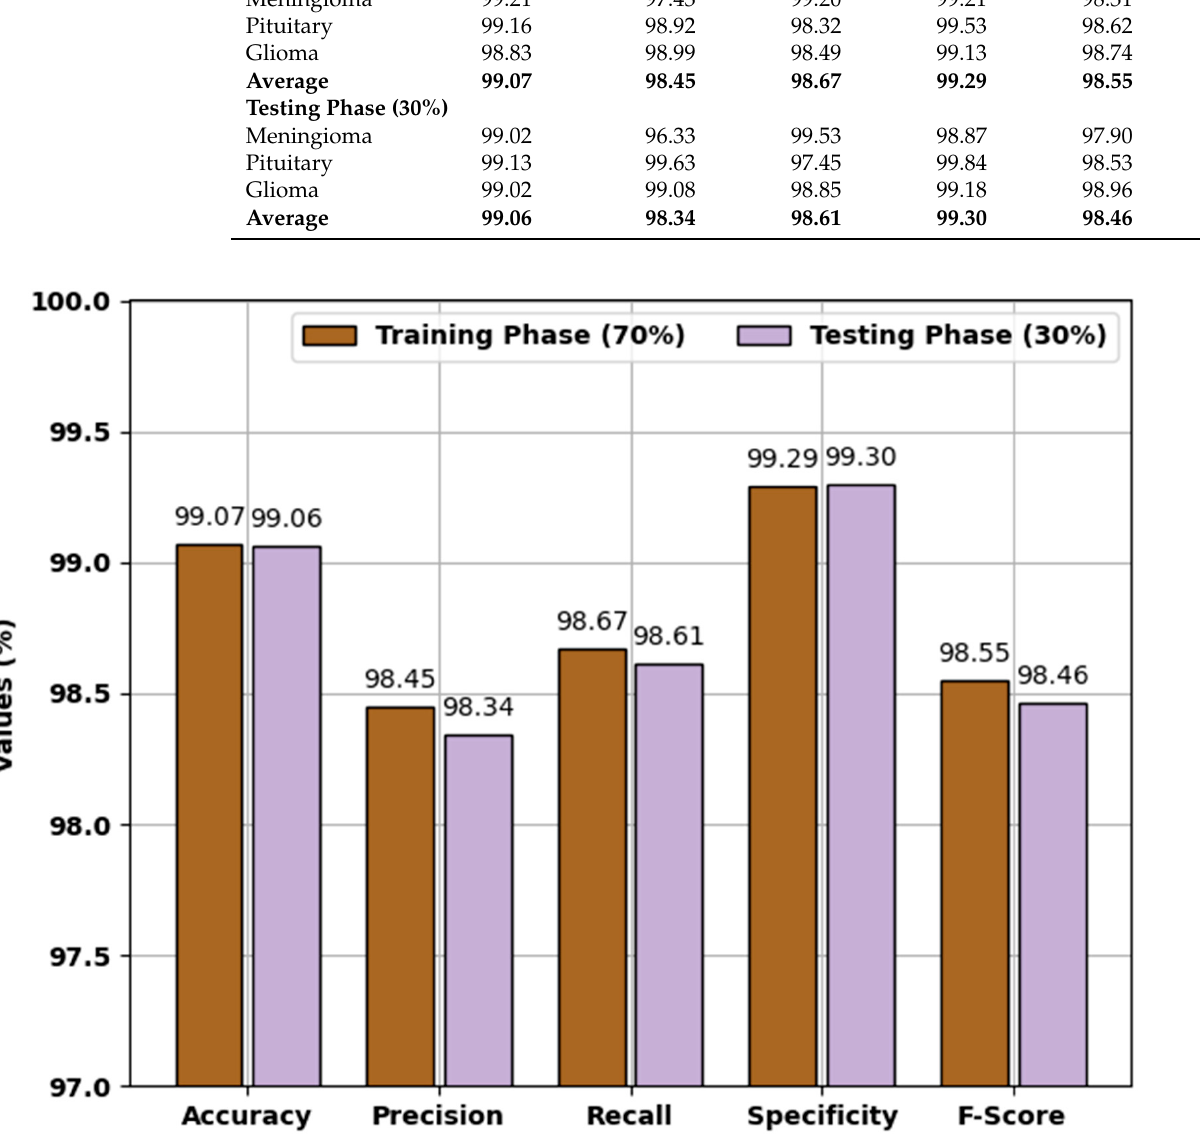
Figure 6. Result analysis of EADL-BTMIC technique on 70% of TR and 30% of TS data. For sample, with 70% of TR data, the EADL-BTMIC technique attained enhanced accu y , prec n , reca l , spec y , and F score of 99.07%, 98.45%, 98.67%, 99.29%, and 98.55%, corre- spondingly. Simultaneously, with 30% of TS data, the EADL-BTMIC approach reached increased accu y , prec n , reca l , spec y , and F score of 99.06%, 98.34%, 98.61%, 99.30%, and 98.46%, correspondingly.